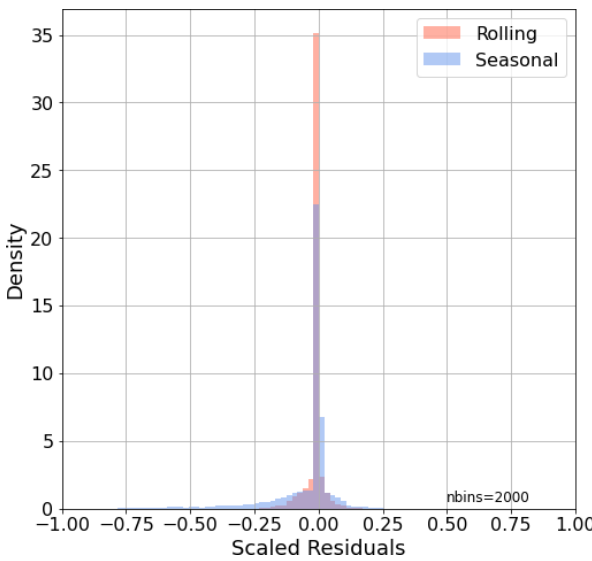
Figure 7. Normalised scaled residuals histogram for both PMF techniques. Table 2. Q/Q exp values for rolling and seasonal solutions. Bold figures represent the lowest value in the rolling – seasonal compari-